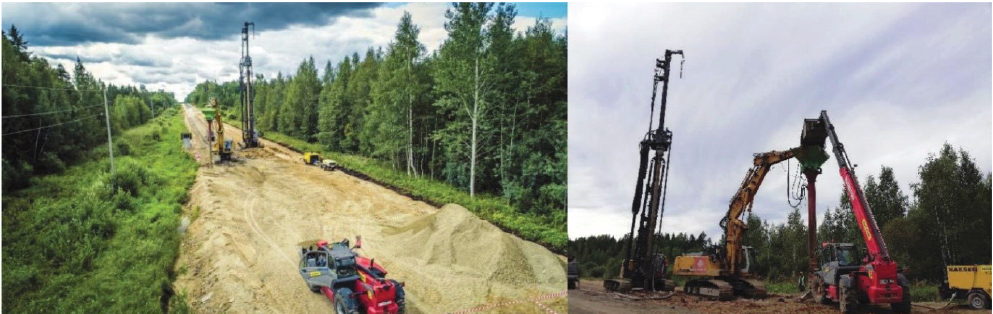
Figure 2. Construction of combined columns and pile